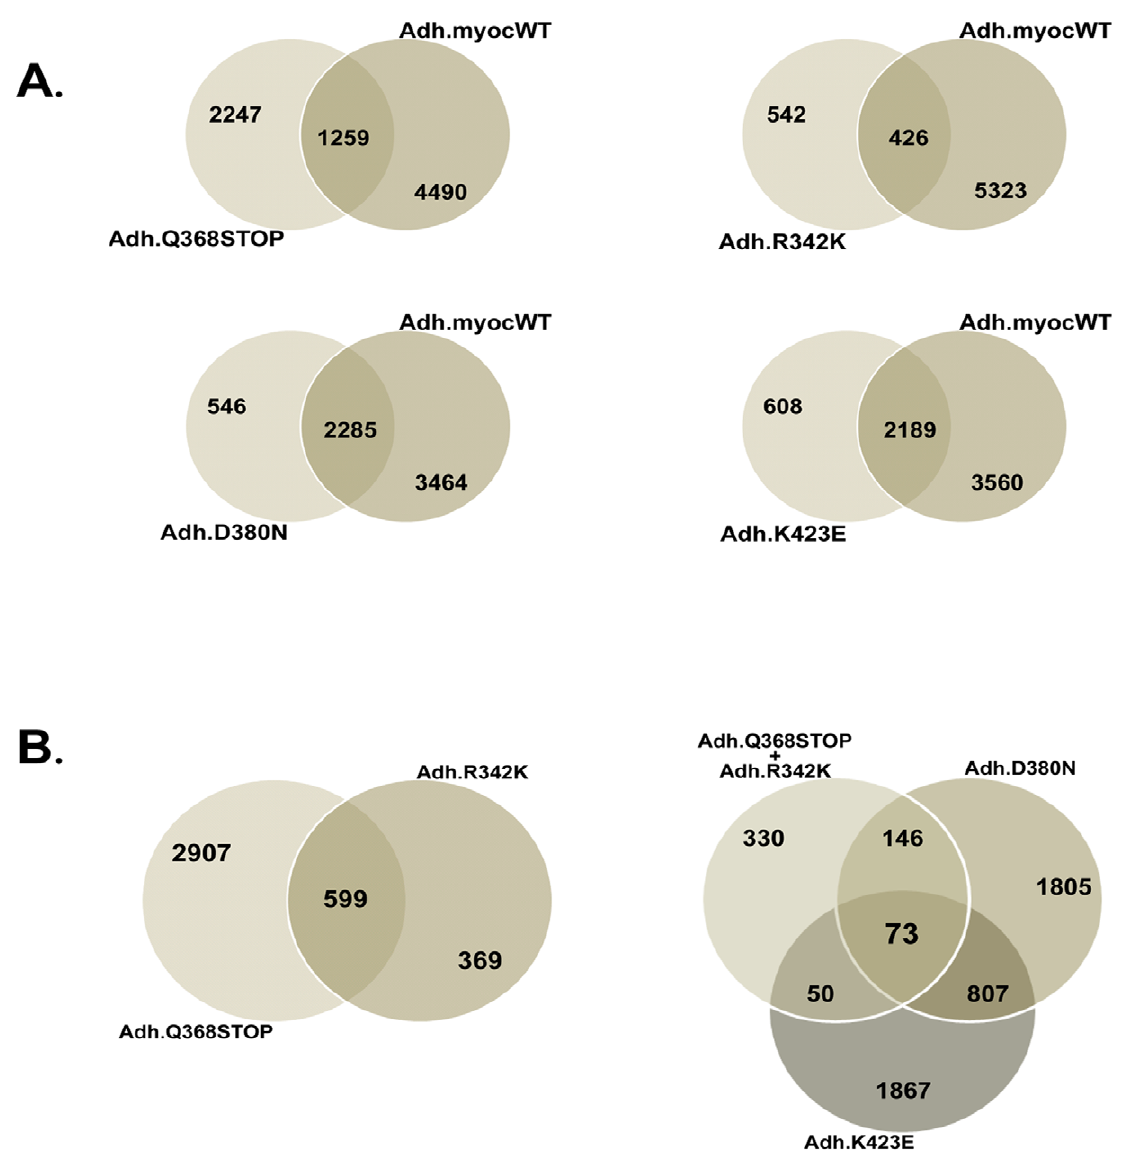
Figure 6. MYOC mutants shared different gene percentages with MYOC wild-type, and shared 73 genes among themselves. Venn diagrams of genes differentially altered 1.5-fold in response to overexpression of MYOC wild-type and MYOC- mutants. Each circle represents one condition. Intersections indicate numbers of genes that are shared between the different conditions. A) genes shared of each of the mutants with the wild-type. B) genes shared by all mutants. Genes selected from each of the lists of the subcategories are shown in Figure 7 lower panel. As expected, some of these genes coincide with those selected above through other selection means, ratifying the relevance of their potential involvement in the association of MYOC mutants with glaucoma. Among the genes, we observed the signaling cytokine CXCL12 , the vasoconstrictor EDN1 , the extracellular matrix constituent ECM2 , the cysteine protease CSTA , the calcium homeostasis proteins STC1 , STC2 and the growth factors IGF1 and FGF1 . It is likely that a different extent combination of the functions encoded by these genes is what it would cause the MYOC mutants to trigger the development of the disease.